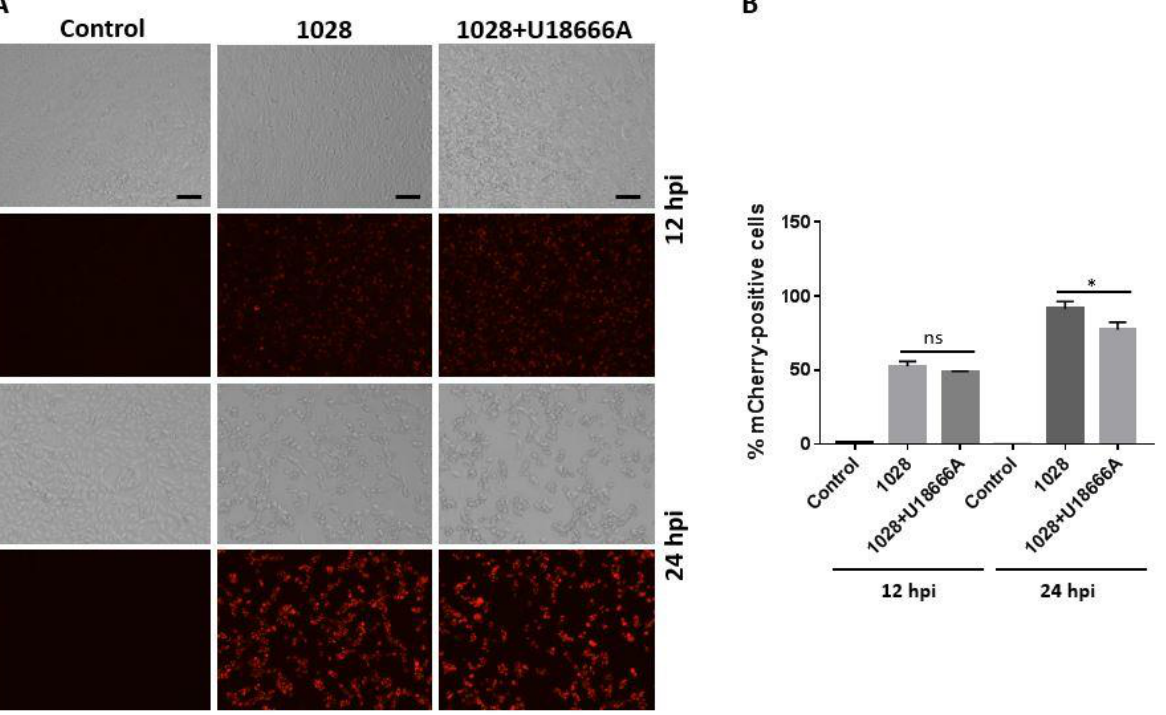
Figure 6. U18666A treatment causes a reduction in VP26-mCherry signal in PK-15 cells infected with PRV 1028. ( A ) PK-15 cells were infected with PRV 1028 (MOI = 5) in the presence of U18666A (5 μg /mL) or DMSO (0.1%, v / v ) as a control. Infected cells were subjected to fluorescent microscopy